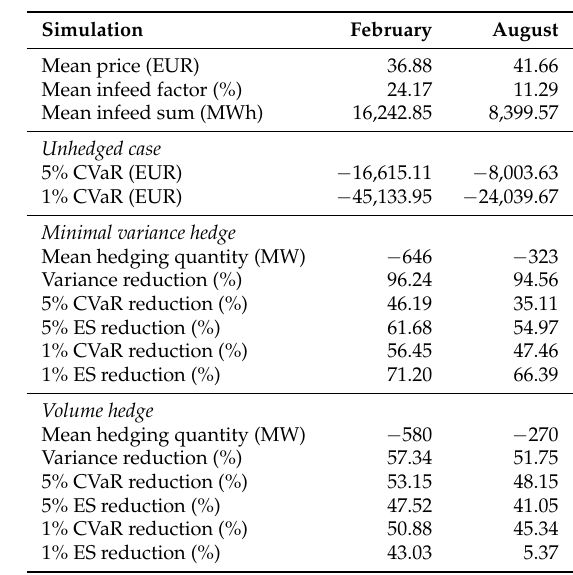
Table 5. Risk assessment for the overall portfolio with and without hedging. Both hedging methods reduce variance and CVaR significantly, with the minimal variance hedge outperforming the volume hedge with respect to expected